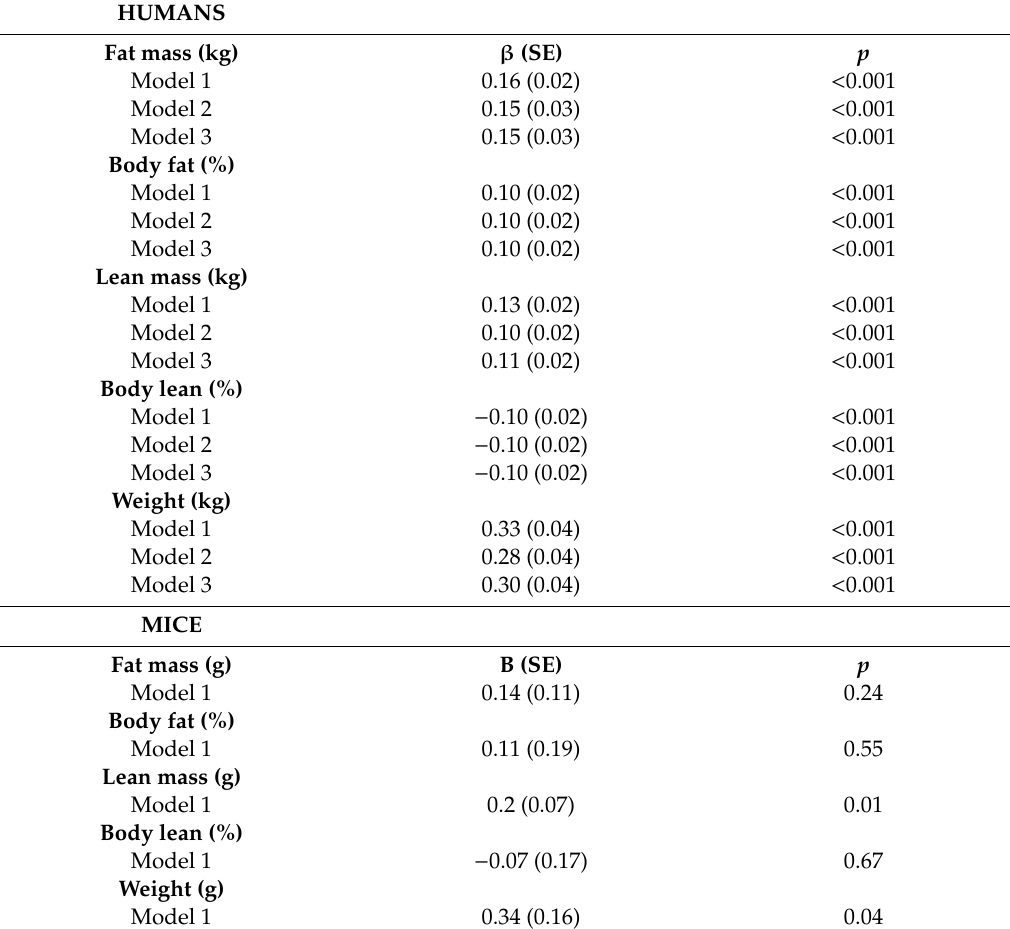
Table 1. Regression coe ffi cients (and SE) for change in body composition and macronutrient intake per unit of